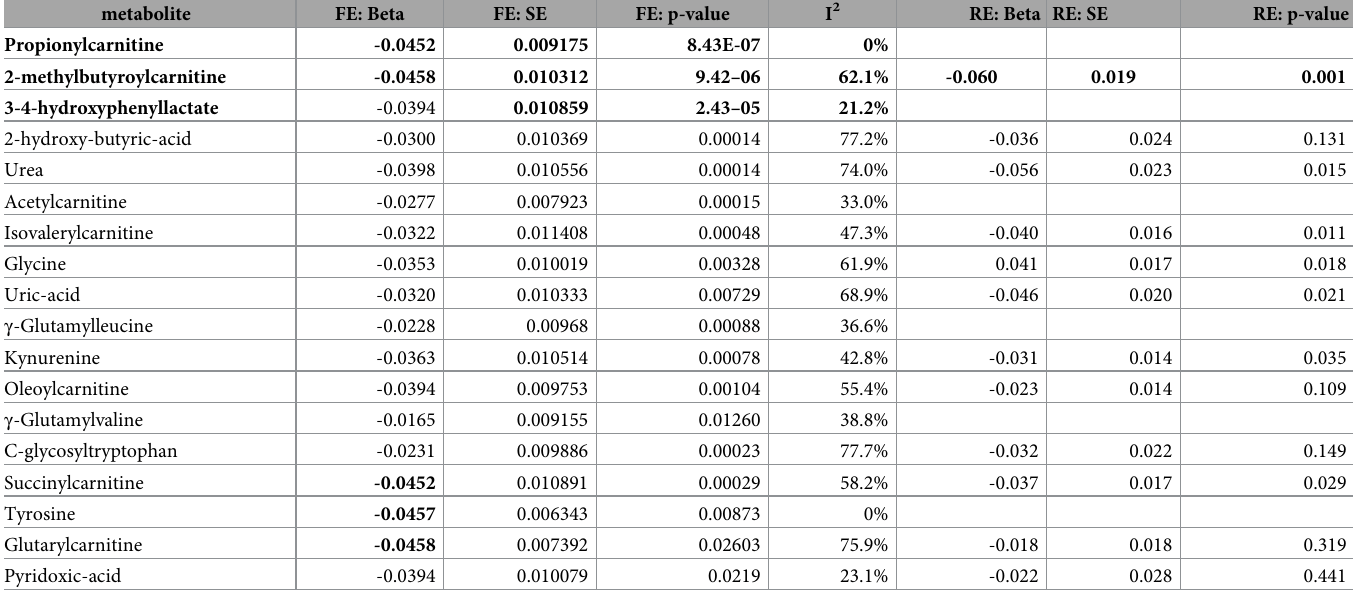
Table 4. Meta-analysis of metabolites showing nominal evidence of association in both sexes (adjusted for age and BMI). Fixed effects (FE) summary effect sizes with standard errors are shown for all metabolites showing a p < 0.05. Random effects (RE) for those where heterogeneity (I 2 ) is higher than 40% or with a Cochrane’s Q <